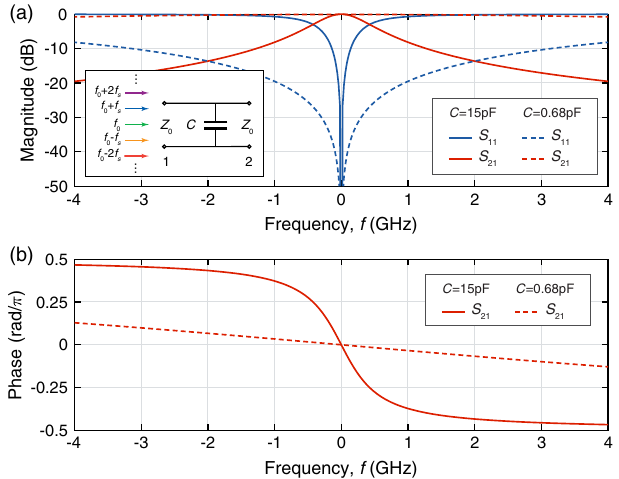
FIG. 2. (a) Amplitude of the scattering parameters of the shunt capacitance C shown in the inset as a function of the frequency (with negative frequencies included). The reference impedance is Z 0 ¼ 50 Ω . The inset shows the shunt capacitor network being excited by a multitone signal containing only a discrete set of harmonics f 0 þ nf with n ¼ 0 ; (cid:3) 1 ; (cid:3) 2 ; … . (b) Phases of the s corresponding parameters S 21